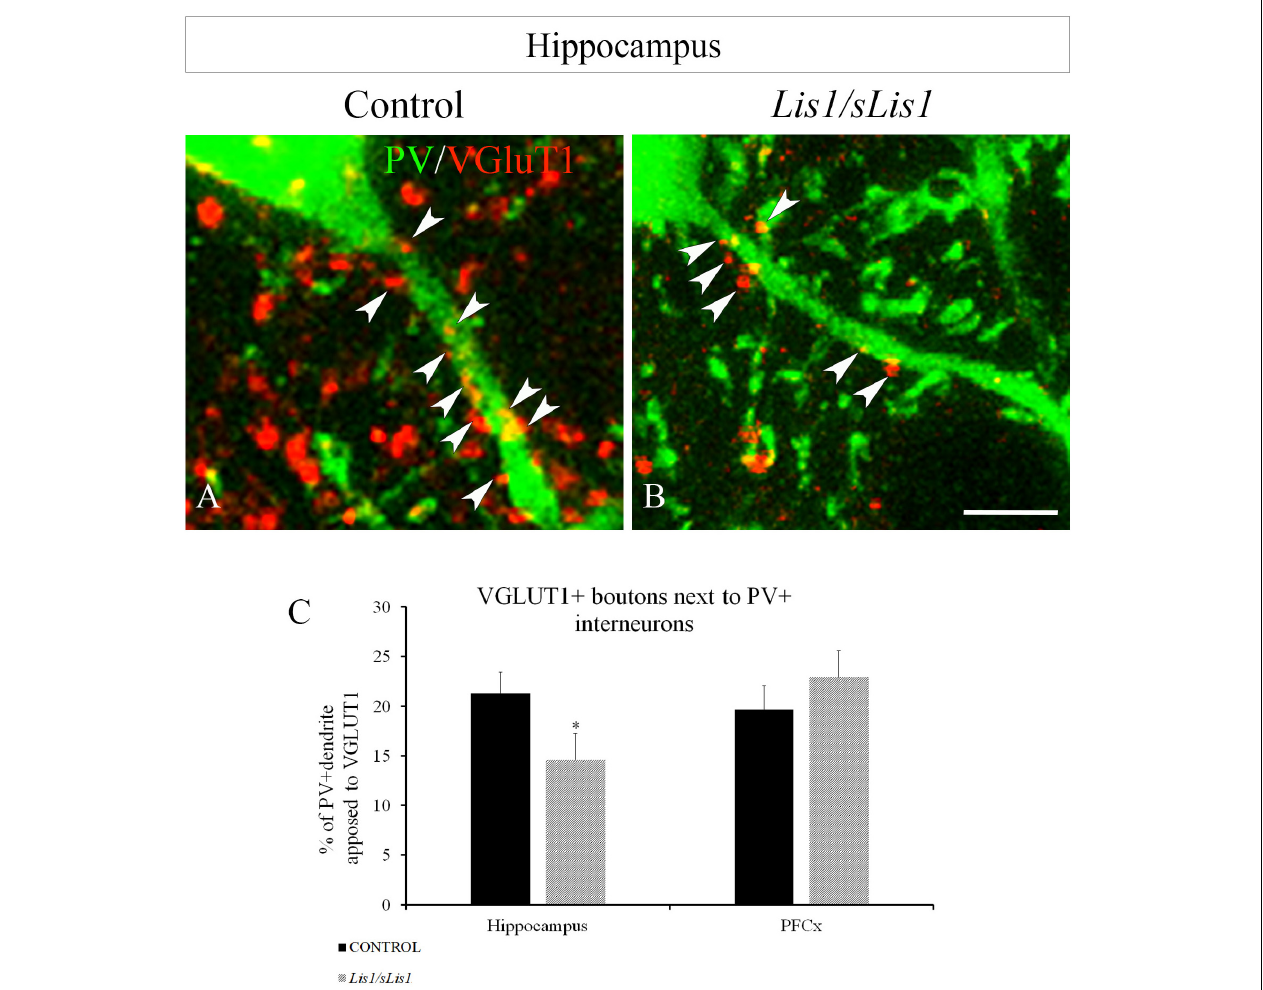
FIGURE 3 | VGLUT1+ boutons next to PV+ interneurons in the hippocampal area (all CA1-3 and DG) in control and Lis1/sLis1 mutant mice. (A,B) PV+ interneurons displayed in green and VGLUT1 boutons in red in control (A) and Lis1/sLis1 mutant mice (B) . (C) The histogram shows the percentage cover of hippocampal and prefrontal PV+ cells with VGLUT1 boutons in Lis1/sLis1 and control mice. The % of PV+ dendrite opposed to VGLUT1 in the hippocampus is reduced in Lis1/sLis1 mutant mice compared to controls. Scale bar 5 µ m in (A,B) .